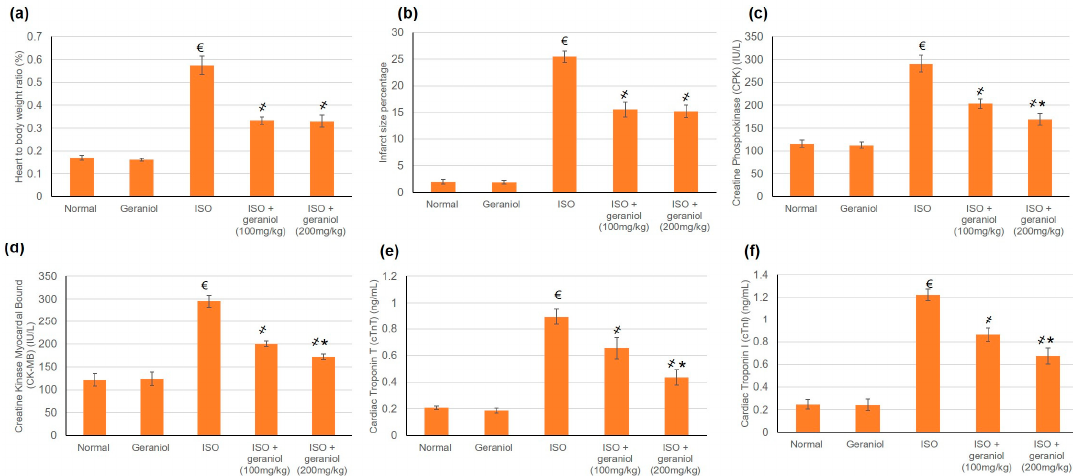
Figure 3. The protective e ff ect of geraniol (100 or 200 mg / kg for 2 weeks) against isoproterenol (ISO)-induced myocardial infraction (MI) as reflected in ( a ) heart-to-body weight ratio, ( b ) infarct area (%), ( c ): creatine phosphokinase (CPK), ( d ) creatine kinase-myocardial bound (CK-MB), ( e ) cardiac troponin T (cTnT), and ( f ) cardiac troponin I (cTnI). All values were stated as mean ± SD ( n = 6). € , p < 0.05 compared to the normal group; compared to the ISO + geraniol (100 mg / kg) group. Comparisons done using one-way ANOVA followed by the Tukey-Kramer post-hoc test. Table 3. Impact of geraniol pretreatment on GSH levels and mitochondrial antioxidant enzymes activities in isoproterenol-induced myocardial infarction.